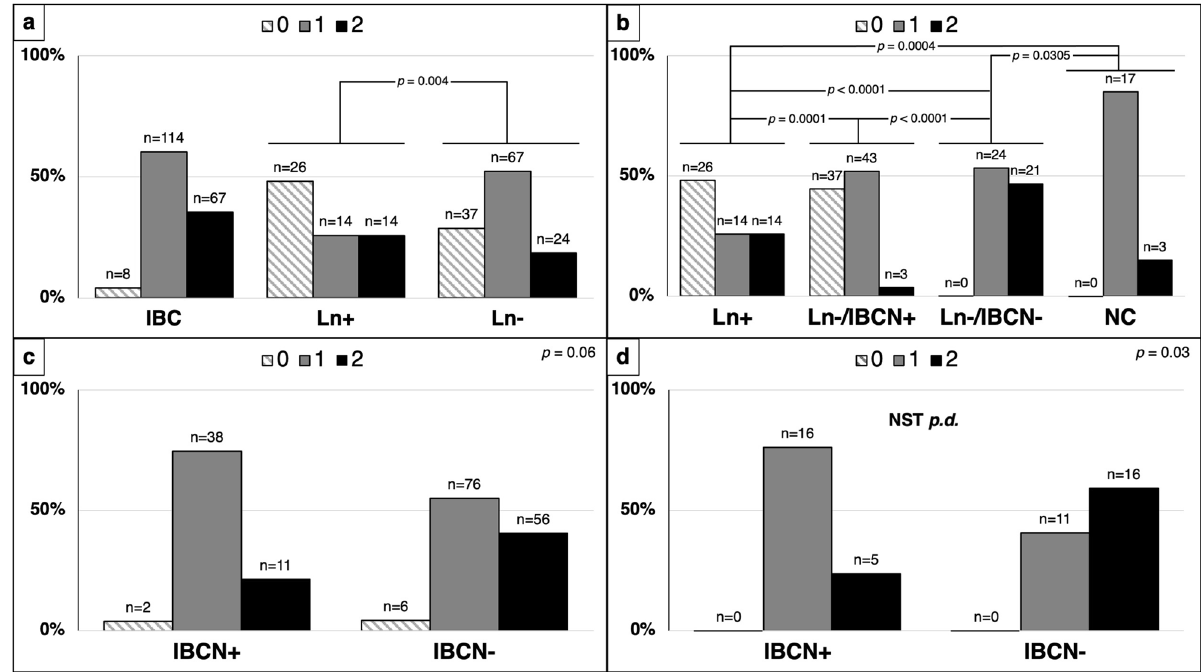
Figure 3. (a) Expression of sCav-1 in primary IBCs and lymph nodes. In contrast to primary IBCs (regardless the nodal status), a high number of metastatic lymph nodes (Ln +) showed score 0 staining for sCav-1. Ln + demonstrate significant lower expression of sCav-1 than lymph nodes without metastasis (Ln−). (b) sCav-1 expression in lymph nodes. From right to left, sCav-1 is increasingly lost from lymph nodes with reactive hyperplasia from cases without nodal metastatic disease (Ln−/IBCN−), through non-metastatic lymph nodes from cases with nodal metastatic disease (Ln−/IBCN +), to Ln + ; lymph nodes of patients with no history of cancer (NC) show undoubtedly high expression of sCav-1, comparable to Ln−/IBCN−, even if slightly lower. (c) Correlation of sCav-1 expression in primary IBCs and nodal status. The histograms show how primary tumors with nodal metastasis (IBCN +) demonstrate lower expression of sCav-1 than primary tumors without metastasis (IBCN−), regardless the grade. (d) Correlation of sCav-1 expression in primary poorly differentiated ( p.d. ) IBCs of no special type (NST) and nodal status. The histograms show how IBCN + demonstrate statistically significant lower expression of sCav-1 than IBCN− in the NST p.d. subgroup. sCav-1 staining was scored semi-quantitatively as 0, 1 and 2 (see